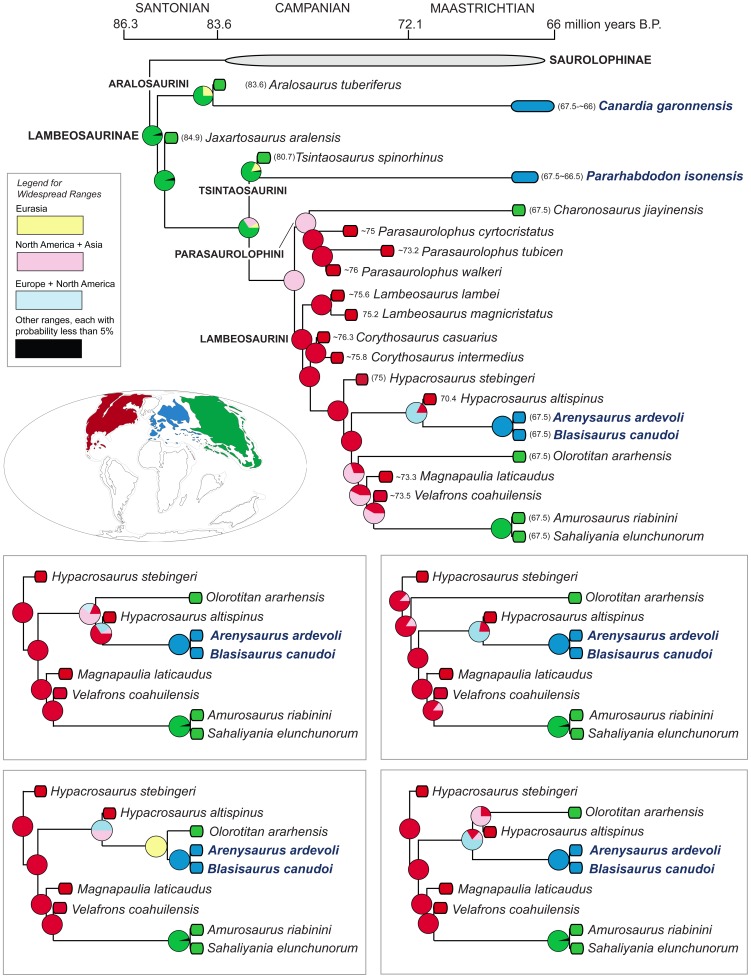
Time-calibrated phylogram of Lambeosaurinae based on the phylogenetic hypothesis shown in Fig. 25.The circles at each node represent the relative probabilities for the ancestral areas inferred using the Bayesian Binary MCMC method (BBM) of Yu et al. [105], implemented in RASP 2.0b [127].